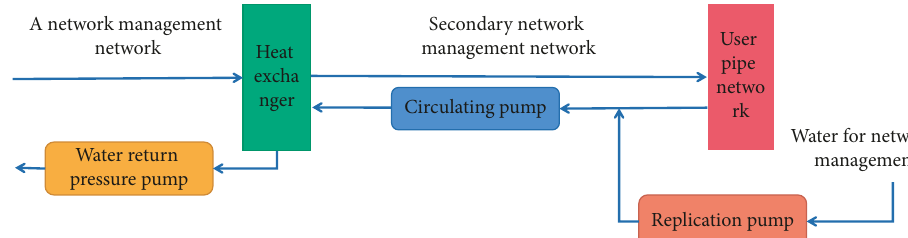
Figure 2: Operation diagram of the heat supply network.